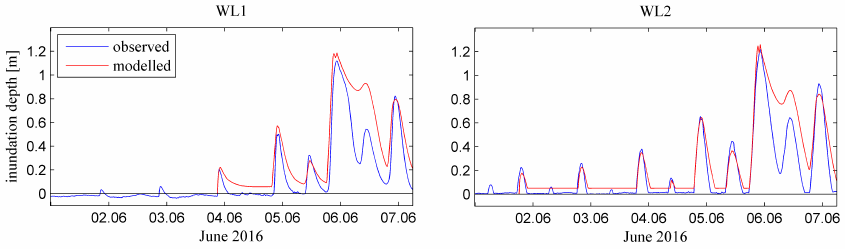
Figure 7. Observed and modelled inundation depth of the June 2016 storm event for two water level loggers on Comerong Islands. Modelled inundation depths result from a model forcing by storm-tide and river discharge using two-open boundaries.